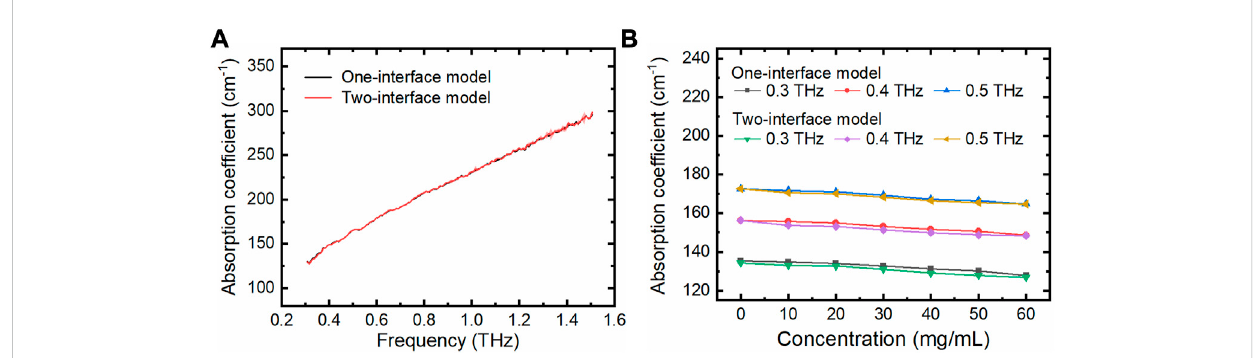
FIGURE 6 LDHsolutionsmeasuredusingtheTHzTD-ATRmicro fl uidicsystem. (A) THzabsorptioncoef fi cientsofLDHsolution(60 mg/mL)areplottedagainst the THz frequency, which were extracted using the two-interface model and one-interface model, respectively. (B) THz absorption coef fi cients of LDH solutionsatspeci fi cTHzfrequenciesareplottedagainsttheLDHconcentrations.ThesolutionwithaLDHconcentrationof0 mg/mLisPBSsolution.The error bars for the three independent experiments are too small to be clearly